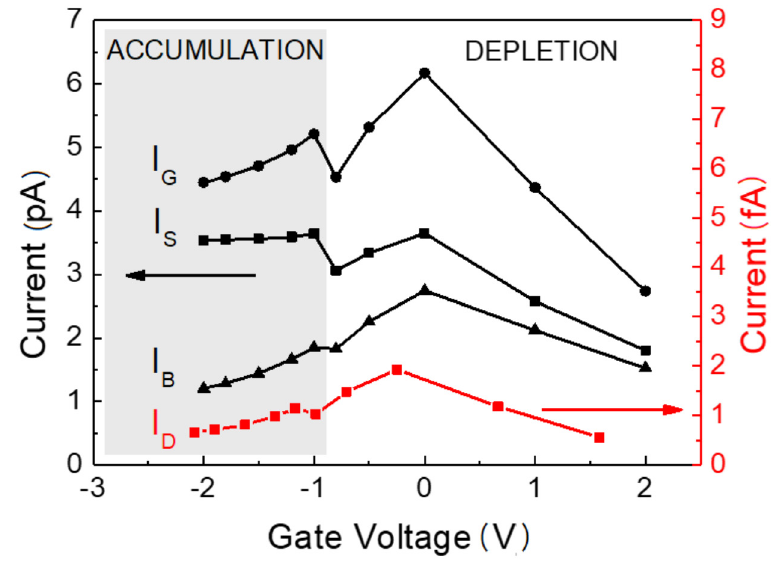
Figure 6. Simulated second harmonic currents toward the four electrodes versus gate bias voltage at 1